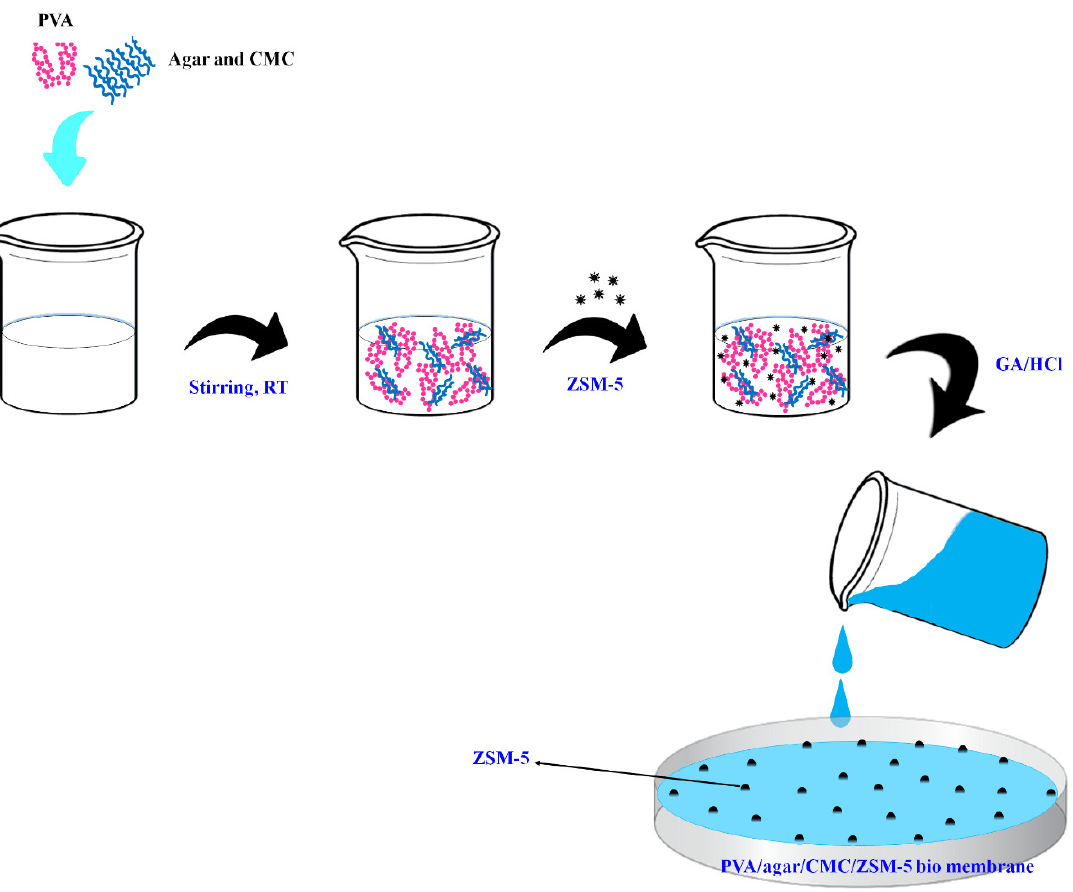
Table 2. The composition of the